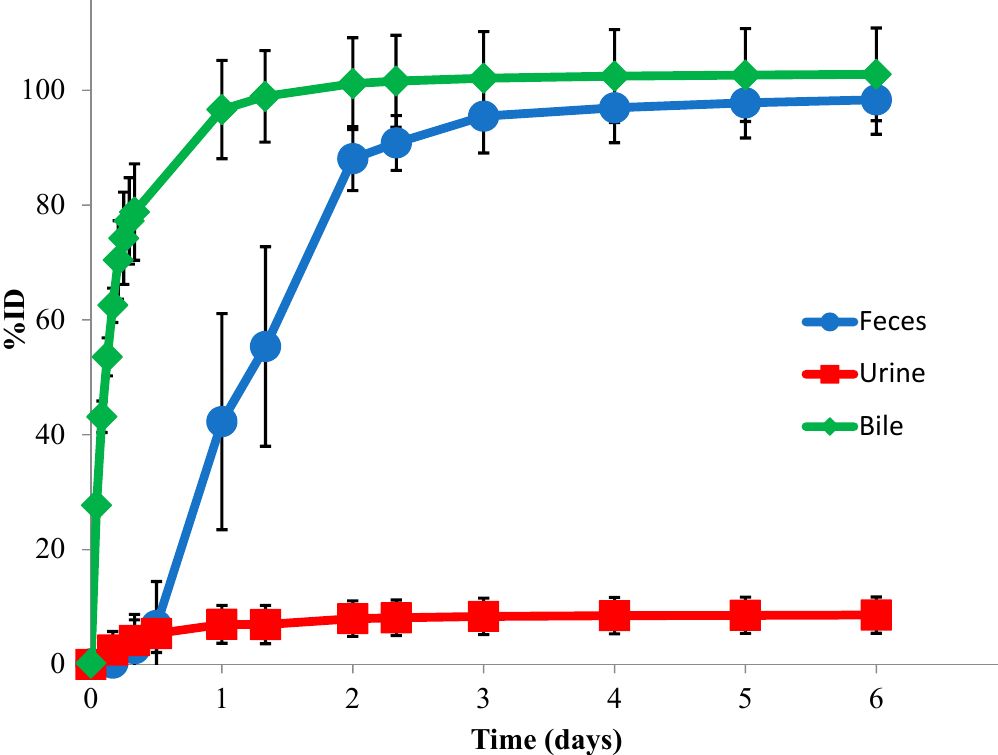
Figure 3. The route of elimination of unconjugated [ 3 H]-MMAE in rats following a single IV administration. The total 3 H radioactivity in feces and urine samples was collected through the study, while bile samples were collected in a separate set of bile-duct-cannulated rats. The data are represented as the mean ± SD. n = 6 per time point up to 24 h (including 24 h), and n = 3 per time point beyond 24 h to the end of the study.